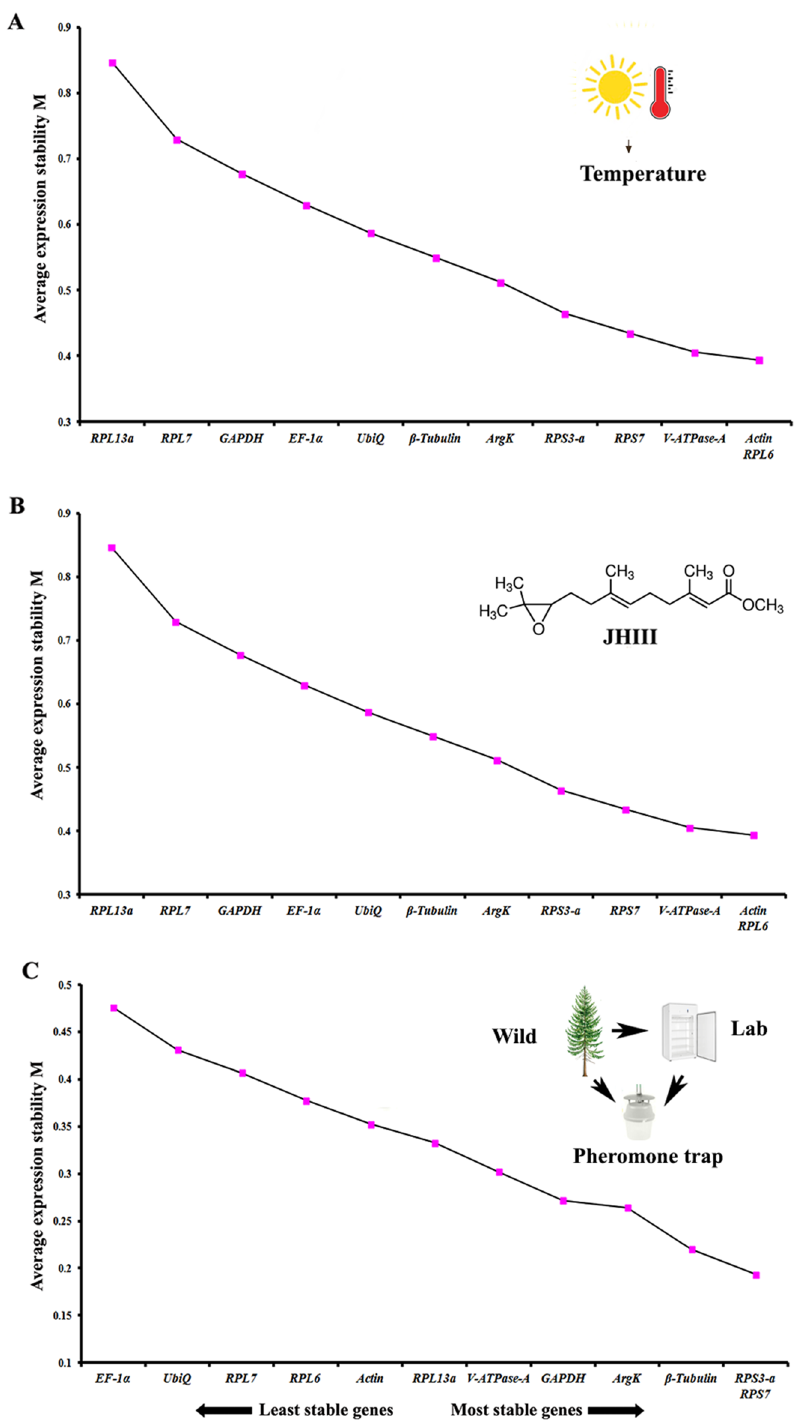
Figure 5. The average expression stability values (M) of twelve reference genes under different conditions calculated by geNorm where the least stable (left) to the most stable (right). ( A ) Temperature, ( B ) Juvenile hormone III, ( C ) Laboratory-reared vs wild